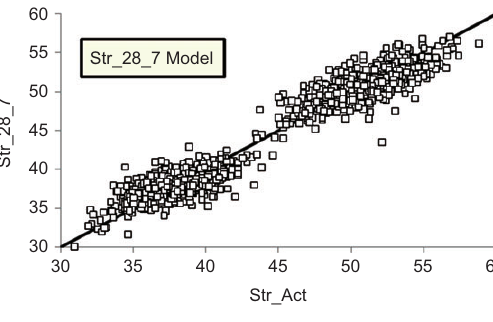
Figure 5 Calculated vs. actual values for the second model.